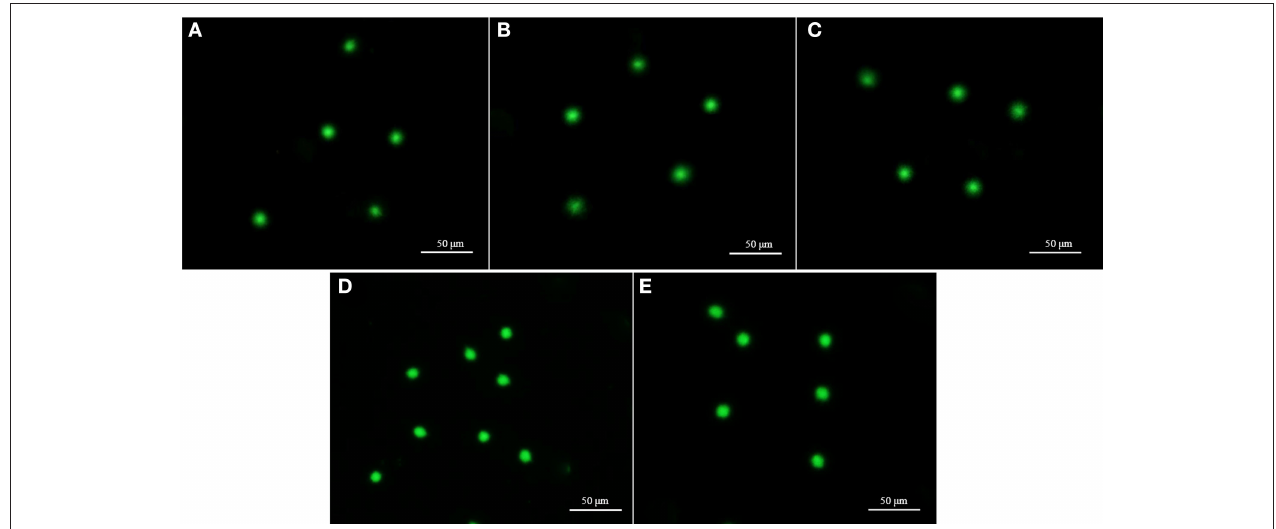
FIGURE 9 | Fluorescent images of fresh and cryopreserved sperm after comet assay. Each comet represents the undamaged DNA in sperm. (A) Intact nuclei of fresh sperm. (B) Intact nuclei of 7-day cryopreserved sperm using extender-1 in combination with 12% GLY. (C) Intact nuclei of 7-day cryopreserved sperm using extender-1 in combination with 15% Me 2 SO. (D) Intact nuclei of 1-year cryopreserved sperm using extender-1 in combination with 12% GLY. (E) Intact nuclei of 1-year cryopreserved sperm using extender-1 in combination with 15% Me 2 SO. The comet gel was stained with Vista green dye.